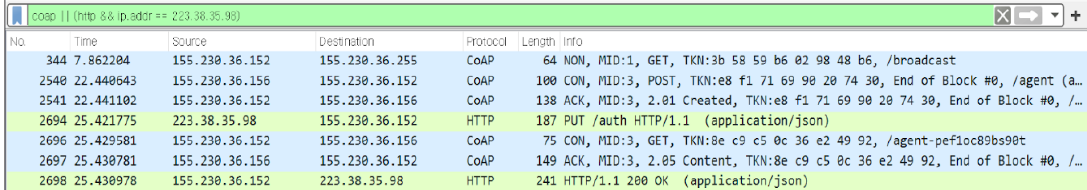
Figure 19. Packet capturing results for IVI agent registration process .